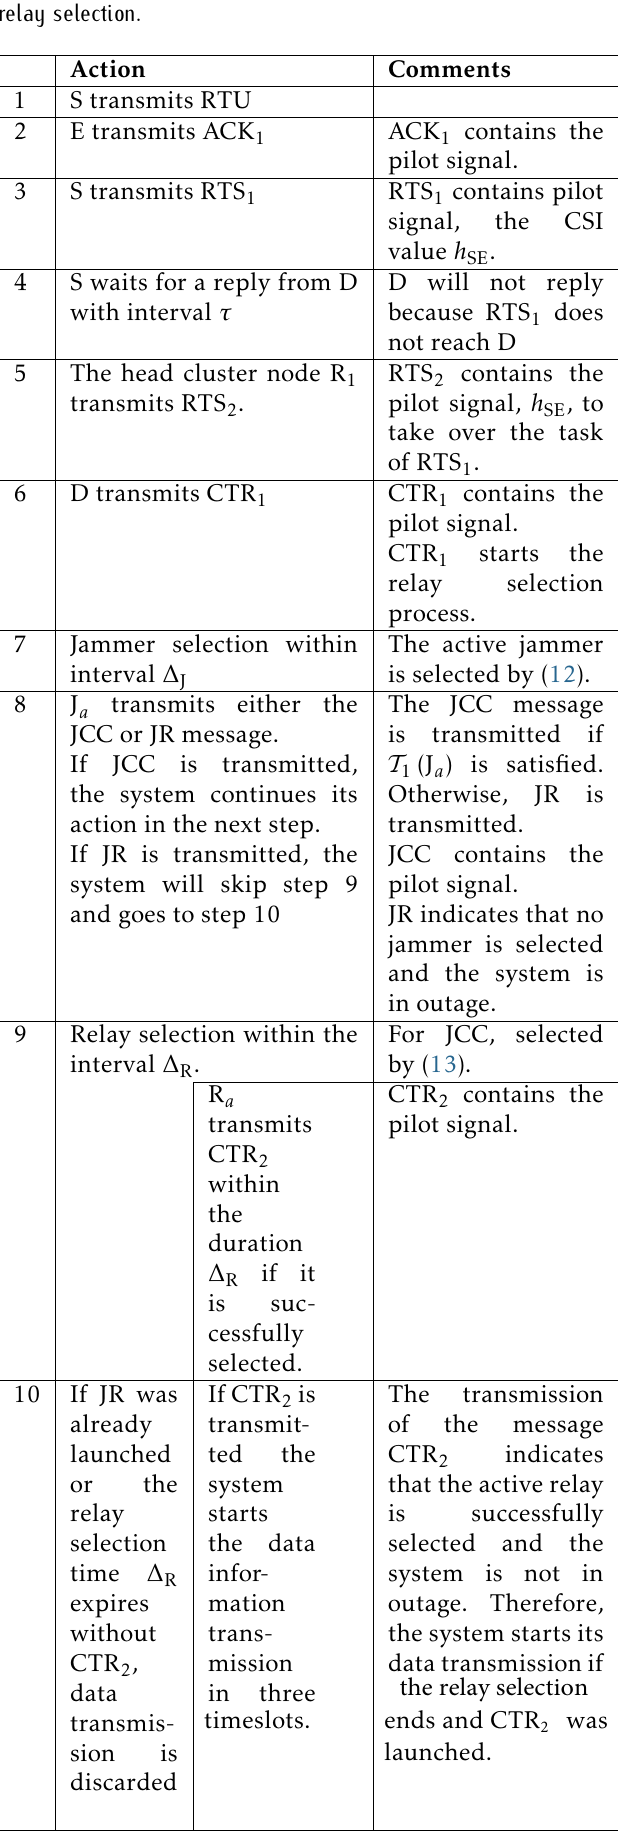
Table 1. Diagram of the description of the jammer, mode and relay